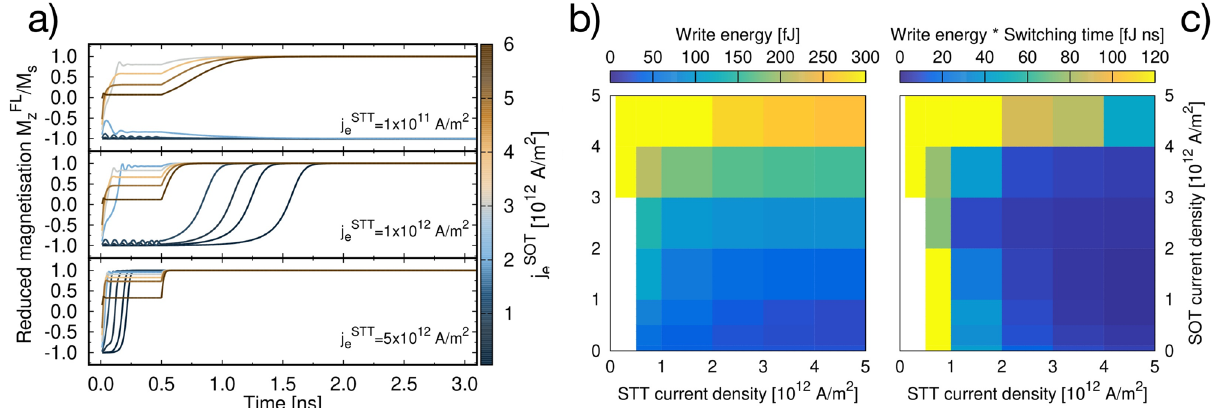
Figure 4. ( a ) Time evolution of the reduced z -component of the magnetisation as a function of j SOT e for = 1 × 10 11 , 1 × 10 12 and 5 × 10 12 Am − 2 . In this case A F = A D and the diameter is 20 nm. ( b ) Write j STT e energy and c) write energy × total switching time as a function of j STT e and j SOT e for A F = A D and diameter of 20 nm. The palette represents the energy in ( b ) and energy × switching time in ( c ), and ranges from blue (low) to yellow (high). White regions correspond to combinations of j STT e and j SOT e that yield no